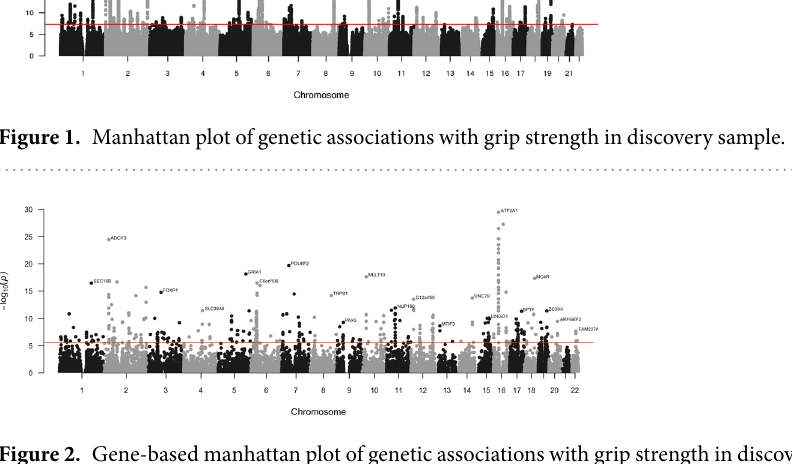
Figure 2. Gene-based manhattan plot of genetic associations with grip strength in discovery sample. The most significant gene for each chromosome is